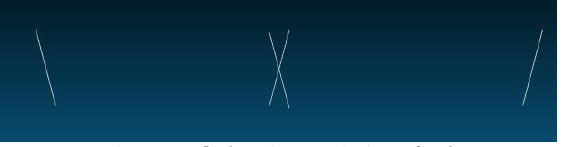
Figure 5: Flight Line Deviation of 30